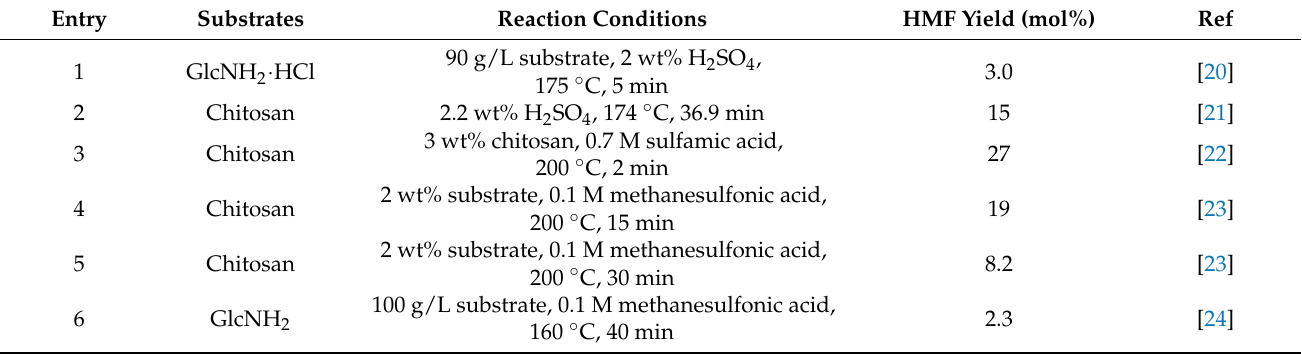
Table 1. Catalytic conversion of chitin biomass to HMF over Bronsted acid catalysts.